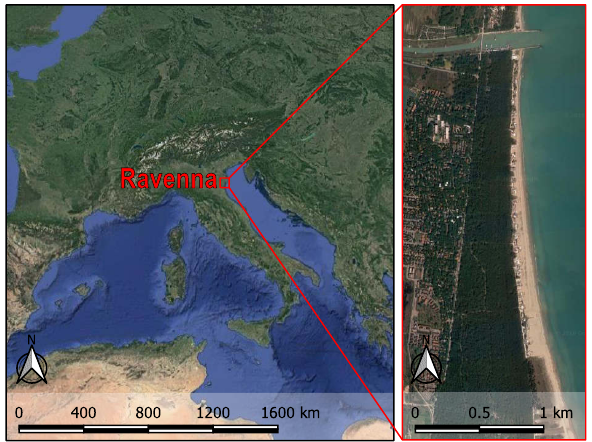
Figure 2. Case study location. Table 1. DJI system specifications.